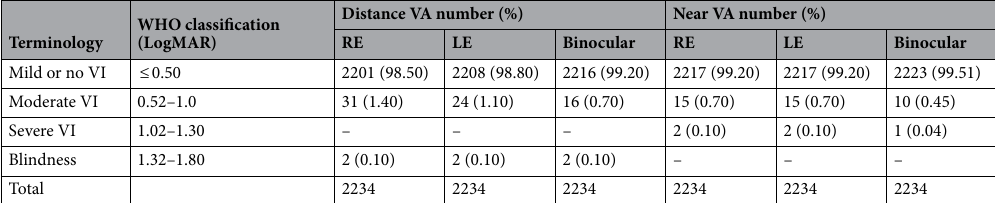
Table 2. Classification of measured habitual VA among all students. RE Right eye, LE Left eye, VI Vision impairment.